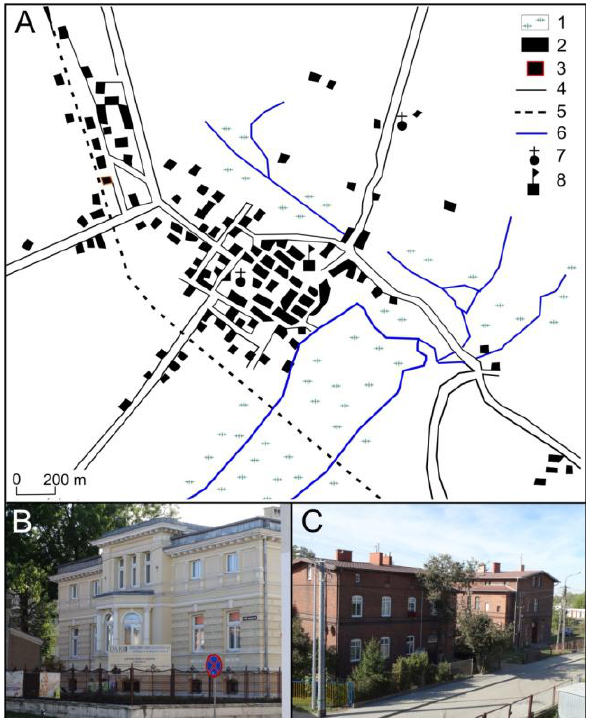
Fig. 2. Spatial layout of Działdowo ( Soldau ) in the 1930s (A), villa in the present day Jagiełły Street (formerly Bahnhofstraβe ) (B) and housing estate for railway employees (C) (Source: author’s own study based on Topographische Karte…, 1938c (A); photo by author (B-C) 1 – wetlands, 2 – buildings, 3 – railway station, 4 –